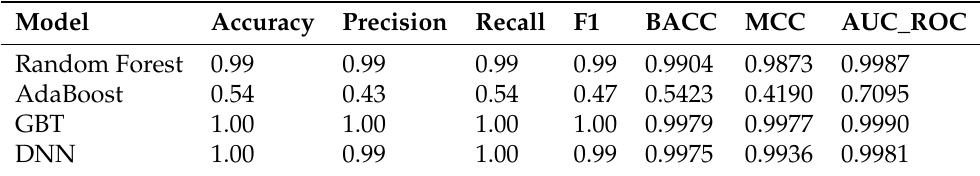
Table 12. Comparison of the models used and their prediction results on test data without SMOTE.